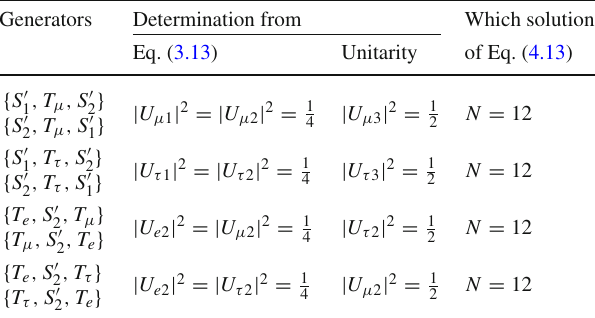
Table1 Allowedgeneratorsforthegroup A 3 (Note:ThisistheCoxeter nomenclature.Thisgroupismorecommonlyknownas S 4 ,andtheGAP identifier of this group is [ 24,12